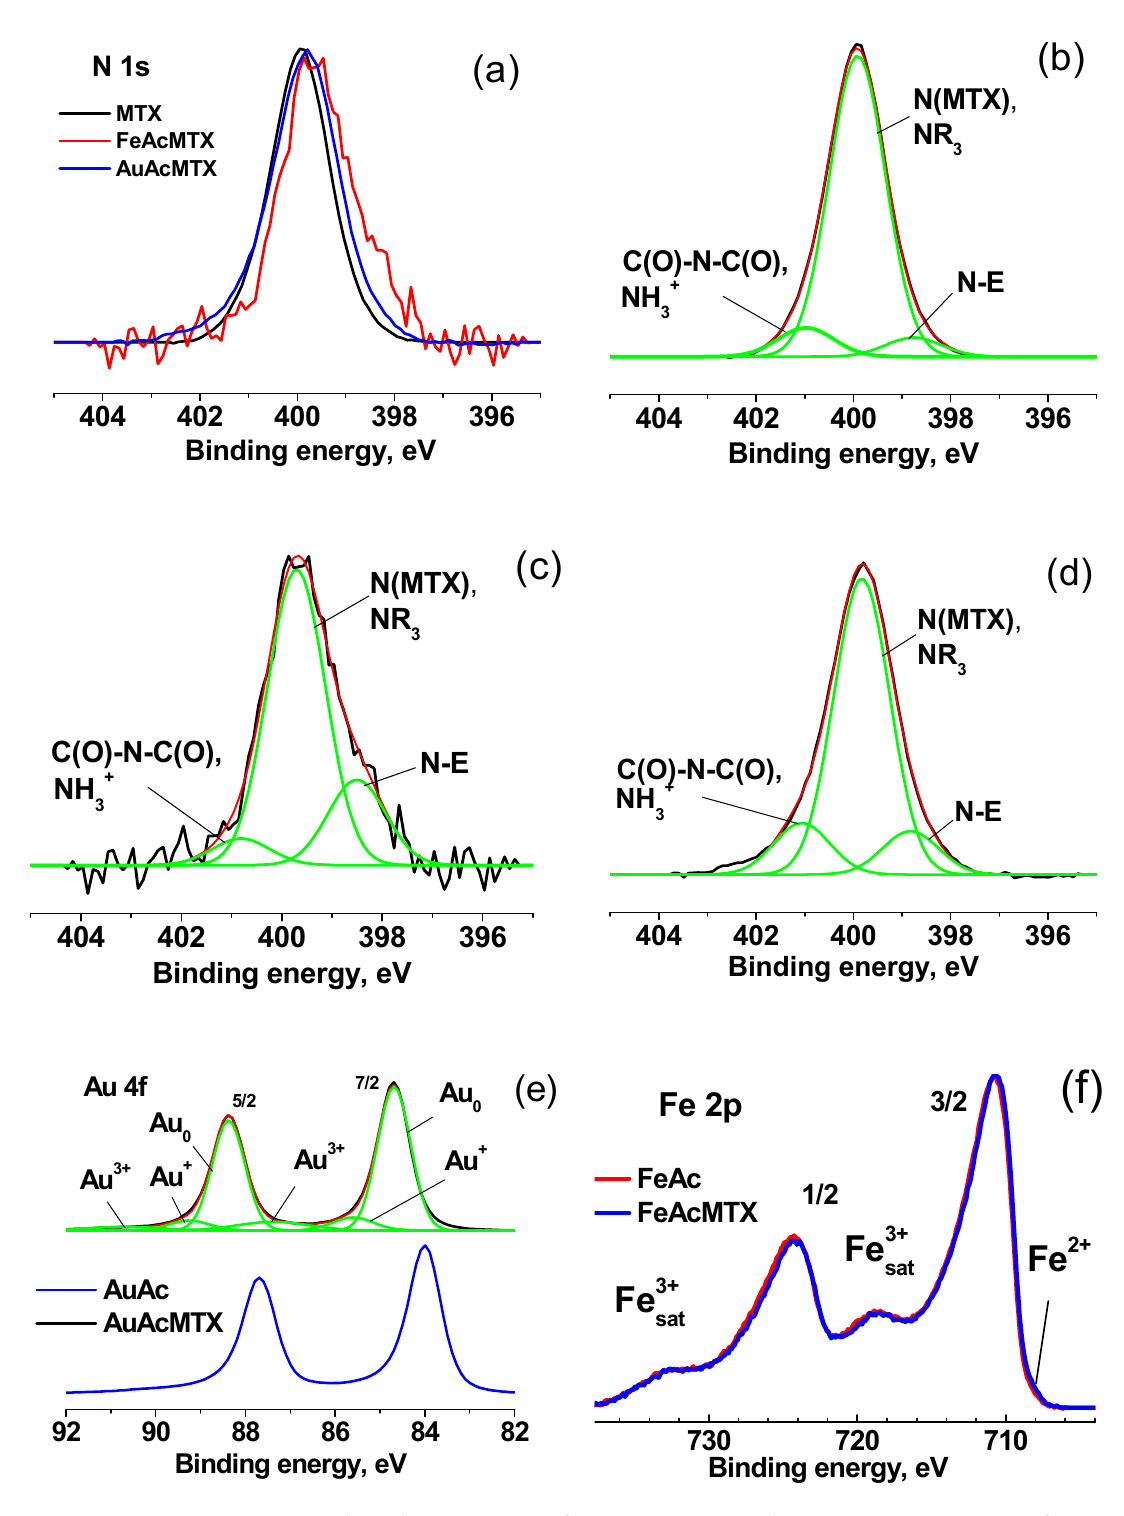
Figure 9. Photoelectron spectra of MTX, FeAcMTX and AuAcMTX: N 1s spectra of MTX, FeAcMTX, and AuAcMTX, normalized by intensity of main peak ( a ); N 1s spectra of MTX ( b ), its conjugates with Fe (FeAcMTX) ( c ) and Au (AuAcMTX) ( d ); Au 4f photoelectron spectra of AuAc AuAcMTX ( e ); Fe 2p spectra of FeAc and FeAcMTX normalized by the intensity of the main peak ( f ).